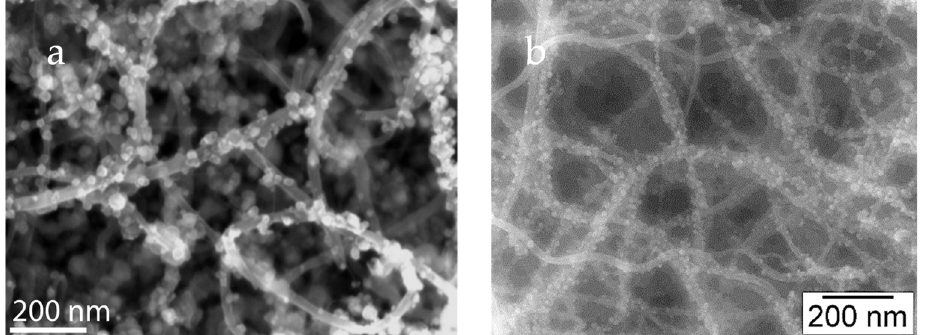
Figure 7. ( a , b ) SEM microstructure of PdNPs well attached on the CNT with fine distribution [138]). “Reproduced with permission from [155]. Elsevier,